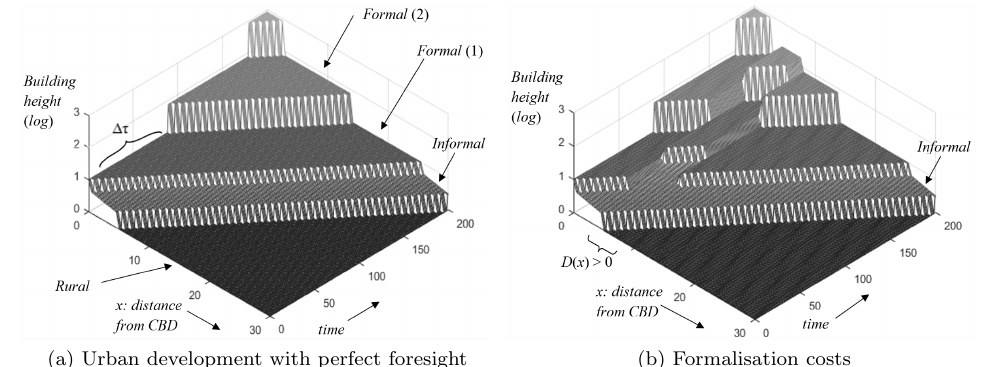
Figure 3: Phases of land-use in city